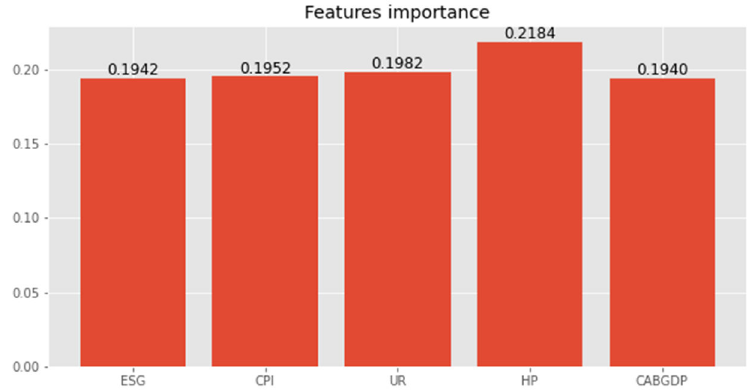
Figure 4. Feature importance.